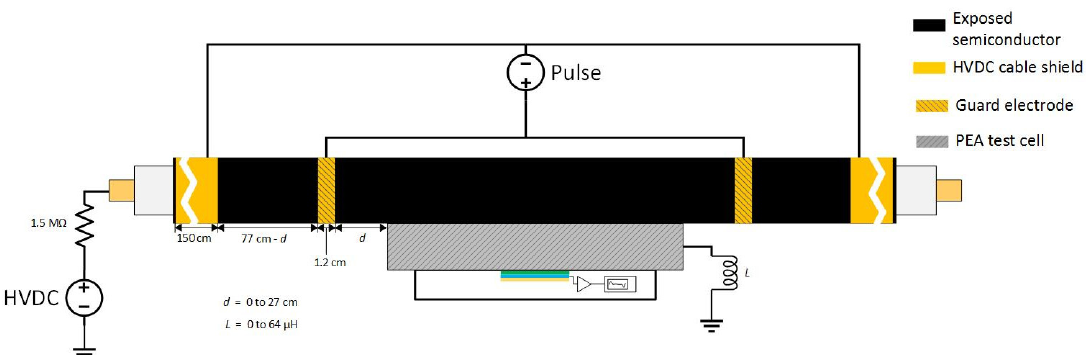
Figure 3. Application of the pulsed voltage at the HVDC test cable using the non-coaxial configuration. “ 𝑑 ” stands for the distance between the injection electrode and the PEA test cell. “ 𝐿 ” is the applied inductance at the PEA test cell grounding.